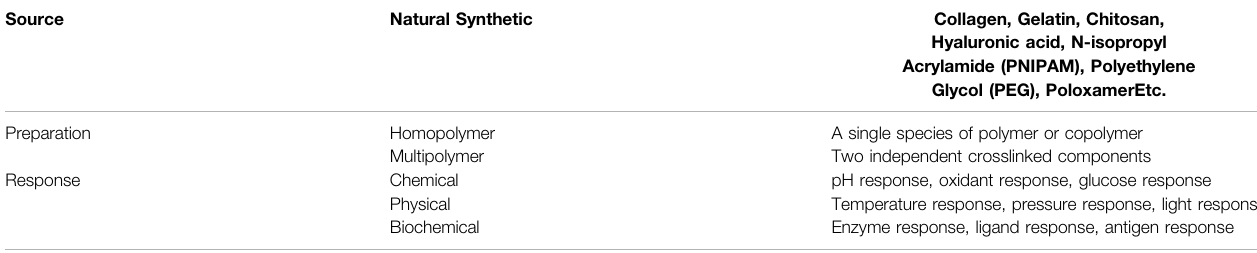
TABLE 1 | Hydrogel classi fi cation.